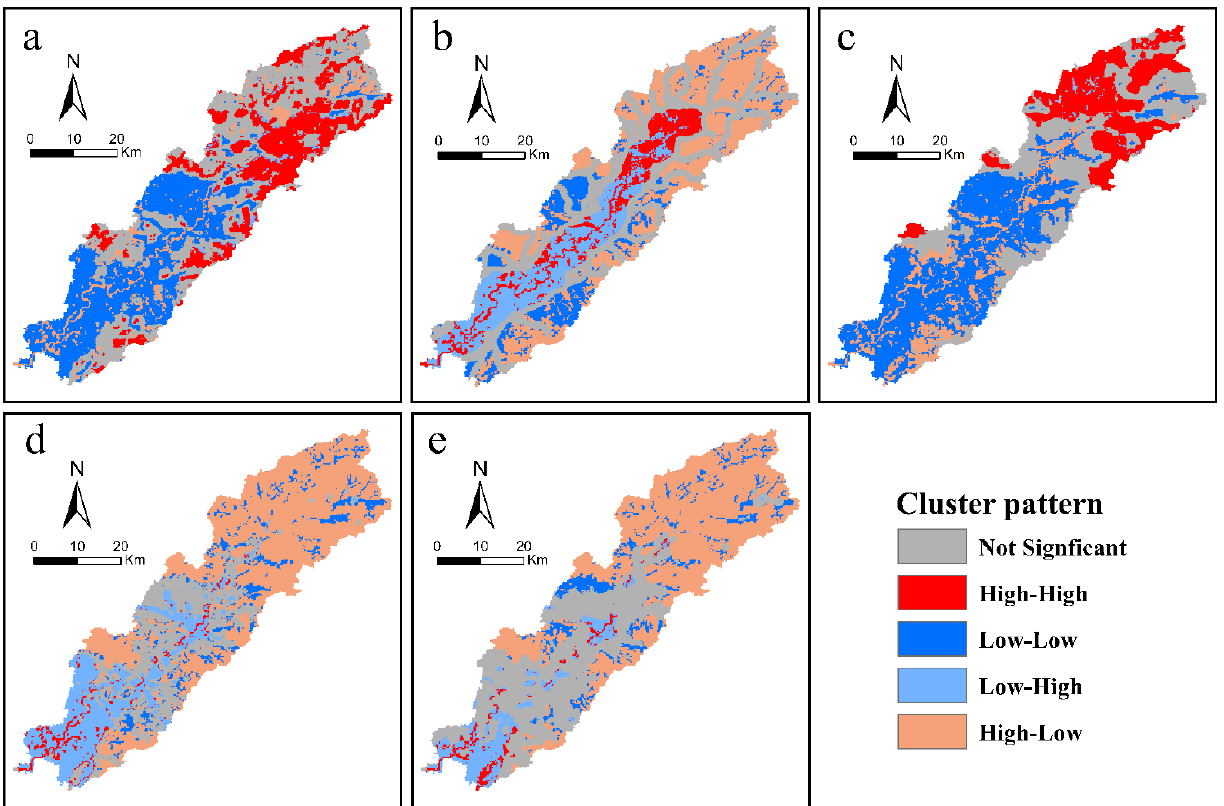
Figure 6. Bivariate LISA cluster maps between ESV and each factor in 2018: ( a ) SLP ( b ) RDC ( c ) GRE ( d ) UR ( e ) POP. SLO, slope; RDC, river distance accessibility; GRE, per capita green area; UR, the proportion of urban and rural human settlements; POP, population.